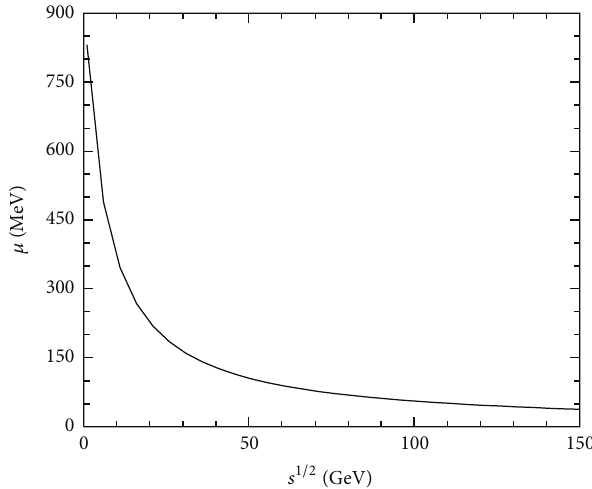
Figure 16: Variation of 𝜇 𝐵 with respect to the √𝑠 𝑁𝑁 .